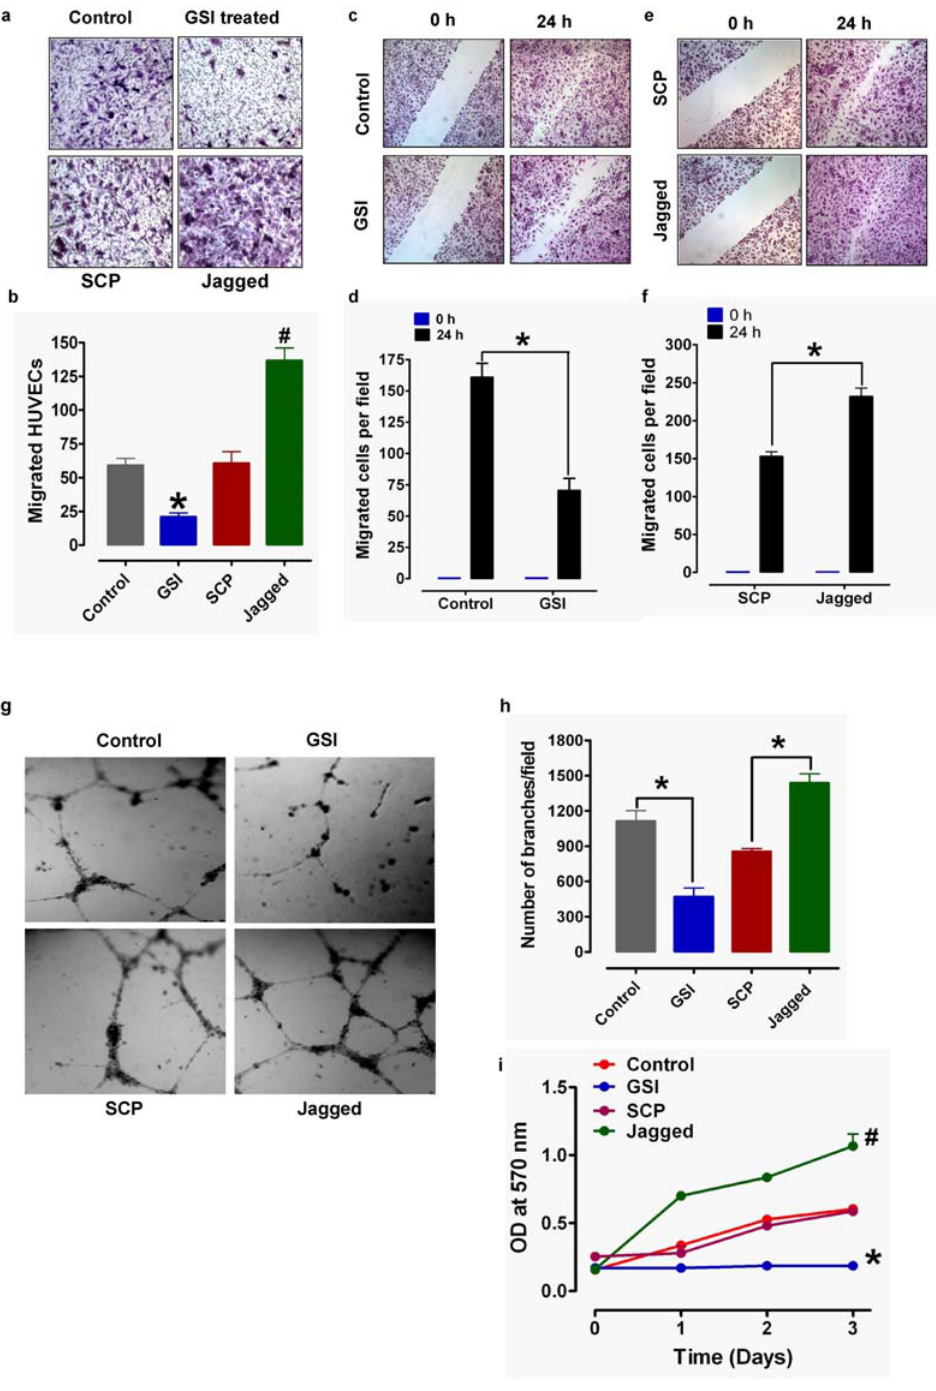
Figure 4. Notch signaling regulates the motility and proliferation of vascular endothelial cells. a and b. Cultured human vascular endothelial cells (HUVEC) were treated with either vehicle (Control), g-secretase inhibitor (GSI; 10 m M DAPT) or Jagged peptide (15 m M) in conditioned medium and plated into chemo-attractant medium consisting regular growth medium with 10% FBS and other growth factors and cell migration was evaluated using a 24 well Transwell chamber assay. Representative images are shown in panel and a and quantitative data are shown in panel b (values are the mean 6 SEM for cells per 100 6 field; n=3-4). *p , 0.001 compared to control values. # p , 0.001 compared to SCP values. c–f. HUVEC monolayers were mechanically wounded with the sterile tip of a 20–200 m l pipette tip following treatment with vehicle, GSI (10 m M DAPT), scrambled control peptide (SCP; 15 m M) or Jagged peptide (15 m M). Representative images are shown in c and e, and quantitative data on cell migration in d and f. Values are the mean and SEM (n=3 separate experiments). *p , 0.001. g and h. HUVEC were seeded on Matrigel-precoated wells and cultured in the presence of low-serum medium with GSI (10 m M DAPT), SCP (15 m M) or Jagged peptide (15 m M). Tube formation, designated as the number of branch points/ 100 6 field) was evaluated 18h after cell plating. Representative images are shown in g and quantitative data in h. Values are the mean and